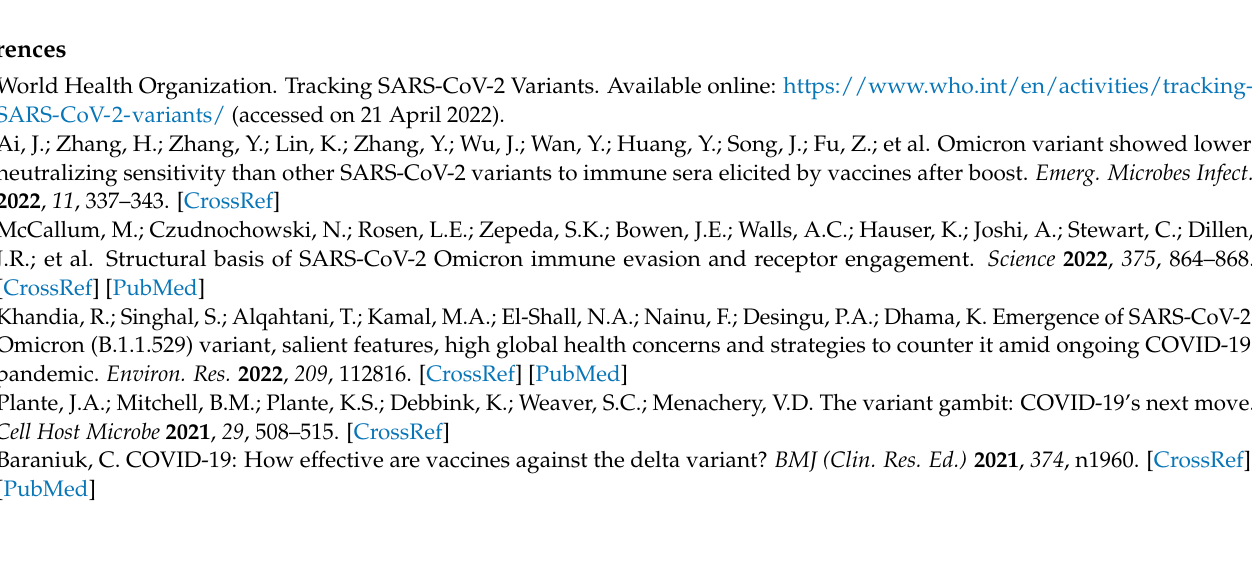
Table S2: Literature search terms used for the Cochrane Library. The final search strategy applied to conduct this meta-analysis is reported at step #20, Table S3: Literature search terms used for Embase. The final search strategy applied to conduct this meta-analysis is reported at step #18, Table S4: Literature search terms used for Medrxiv, Wanfang and CNKI; Figure S1: Forest plot of the pooled log-transformed neutralization titers against the wild type after homologous booster vaccination, Figure S2: Forest plot of the pooled log-transformed neutralization titers against the Beta variant after homologous booster vaccination, Figure S3: Forest plot of the pooled log-transformed neutralization titers against the Delta variant after homologous booster vaccination, Figure S4: Forest plot of the pooled log-transformed neutralization titers against the Omicron variant after homologous booster vaccination, Figure S5: Forest plot of the pooled log-transformed neutralization titers against the wild type after heterogenous booster vaccination, Figure S6: Forest plot of the pooled log-transformed neutralization titers against the Beta variant after heterogenous booster vaccination, Figure S7: Forest plot of the pooled log-transformed neutralization titers against the Delta variant after heterogenous booster vaccination, Figure S8: Forest plot of the pooled log-transformed neutralization titers against the Omicron variant after heterogenous booster